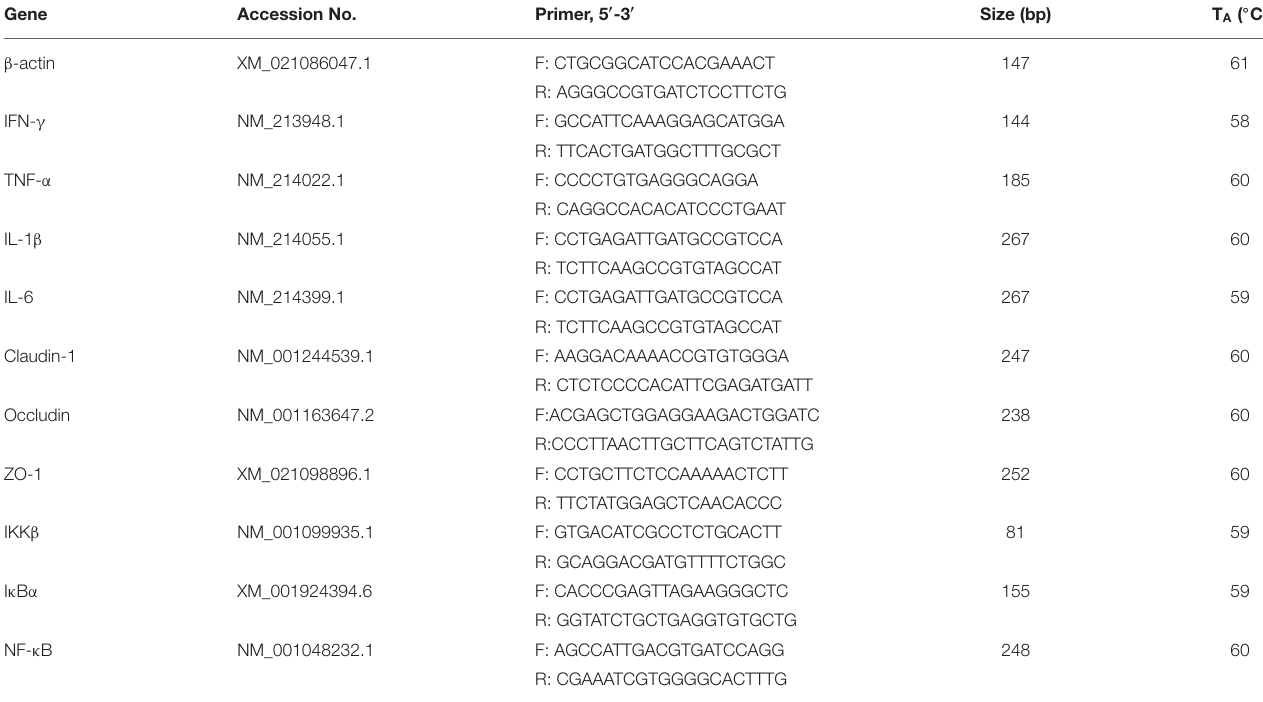
TABLE 2 | Primers used for quantitative real-time PCR.